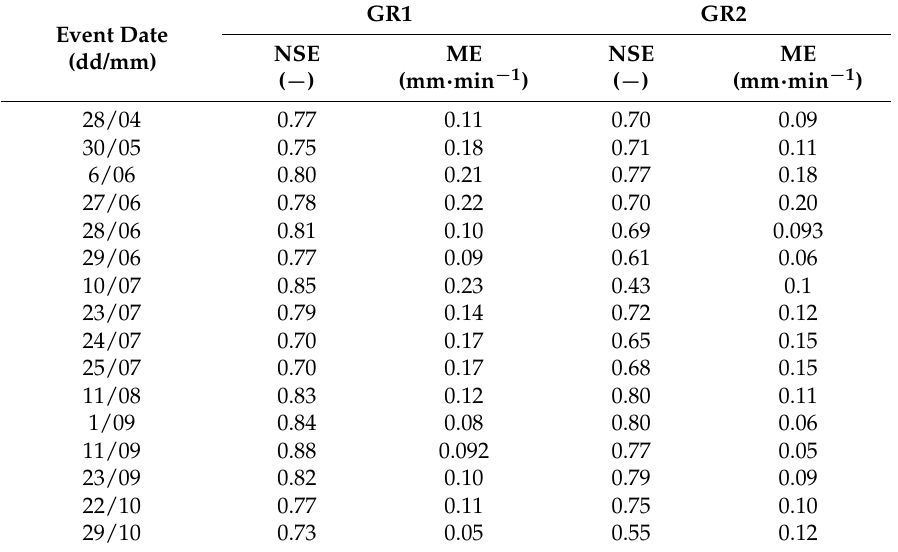
the observed rainfall events used for the